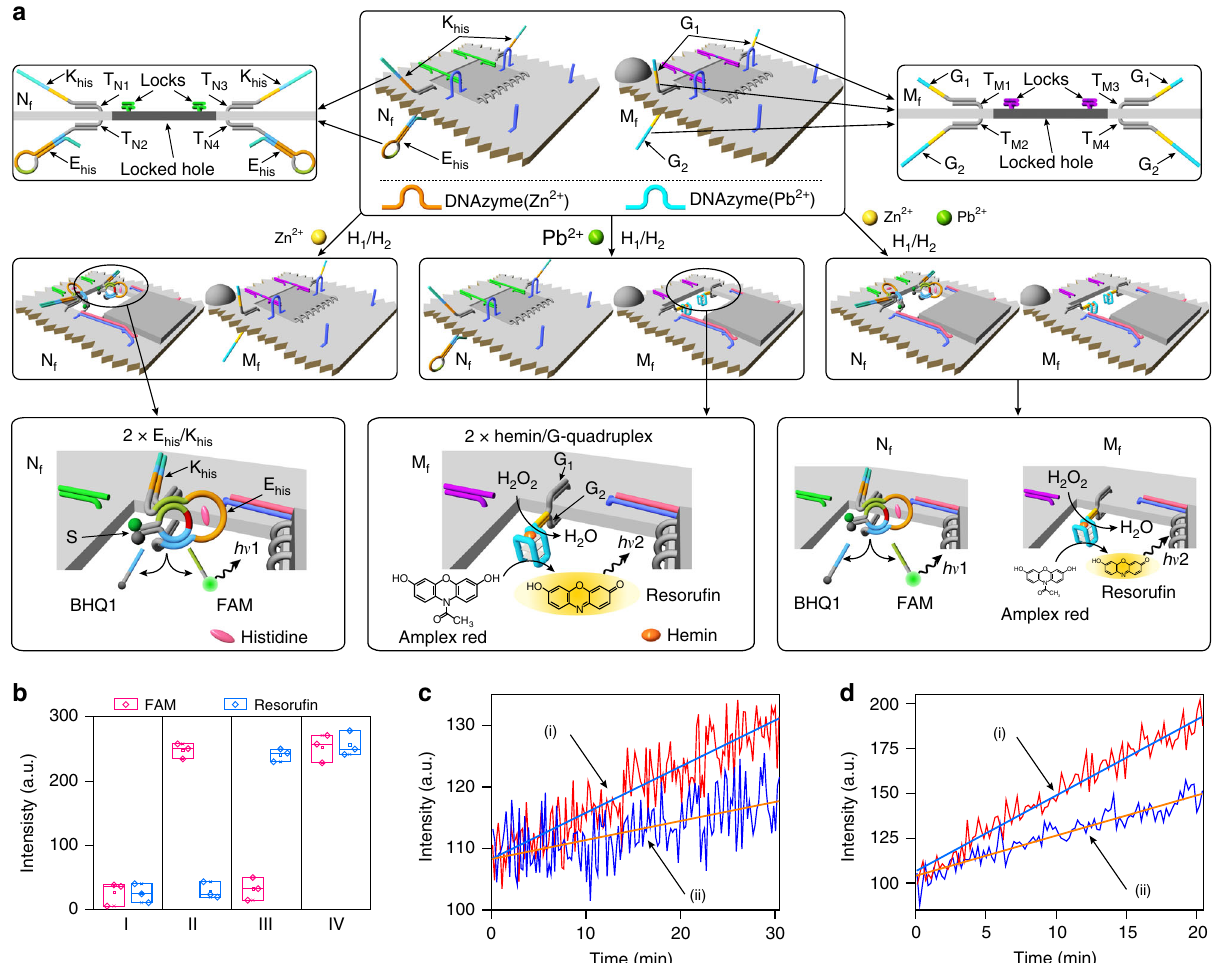
Fig. 3 Programmed catalytic transformation in con fi ned cavities in DNA origami scaffolds. a The mixture of two origami tiles N f and M f , which include the locking/unlocking components for the opening of respective “ window ” domains by the Zn 2 + -ion- and/or Pb 2 + -ion-dependent DNAzymes (Top). Middle- left, treatment of the origami mixture with Zn 2 + ions unlocks the “ window ” associated with tile N f and its opened “ window ” allows the K his strand-induced uncaging of the E his and the activation of the histidine-dependent DNAzyme in the resulting cavity. Middle-center, subjecting the origami mixture to Pb 2 + ions leads to the unlocking of the “ window ” of tile M f . The opened “ window ” in tile M f allows the interaction of the subunits G 1 and G 2 , and the assembly of the hemin/G-quadruplex DNAzyme in the resulting cavity. Middle-right, treatment of the origami mixture with Zn 2 + ions and Pb 2 + ions leads to the unlocking of the two “ windows ” associated with N f and M f . The opened “ windows ” in both tiles allow the activation of the respective catalytic transformations. b Fluorescence outputs (FAM and/or resoru fi n) generated by: Entry I, the locked mixture of N f and M f . Entry II, the treatment of the origami mixture with Zn 2 + ions and the activation of the histidine-dependent DNAzyme in the con fi ned cavity of N f . Entry III, the treatment of the origami mixture with Pb 2 + ions and the activation of the hemin/G-quadruplex DNAzyme in the con fi ned cavity of M f . Entry IV, treatment of the origami mixture with Zn 2 + ions and Pb 2 + ions. Error bars indicate the SD from three independent experiments (for details, see Supplementary Fig. 18). c The catalytic activities of the histidine-dependent DNAzymes in: (i) the con fi ned cavities in the origami tiles N f and (ii) the homogenous identical buffer solution. The concentration of the histidine-dependent DNAzymes in the cavity or bulk solution is identical, 24.6 nM. Source data are provided as a Source Data fi le. d The catalytic activities of the hemin/G-quadruple DNAzymes in: (i) the con fi ned cavities in the origami tiles M f and (ii) the homogenous identical buffer solution. The concentration of the hemin/G-quadruple DNAzymes in the cavity or bulk solution is identical, 17.9 nM. Source data are provided as a Source Data fi